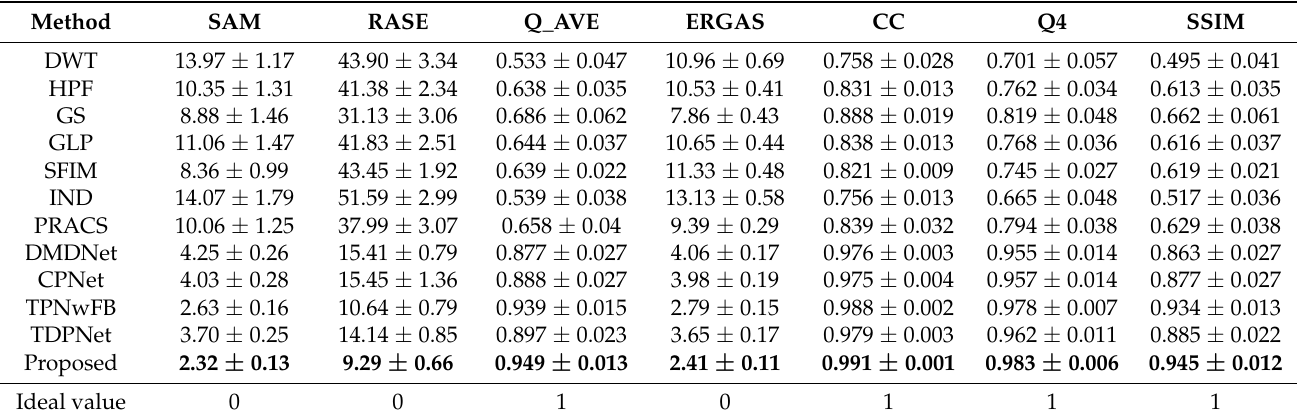
Table 3. Evaluation results on the QuickBird dataset. The mean and deviation values are shown in this table and in the following tables (best results in